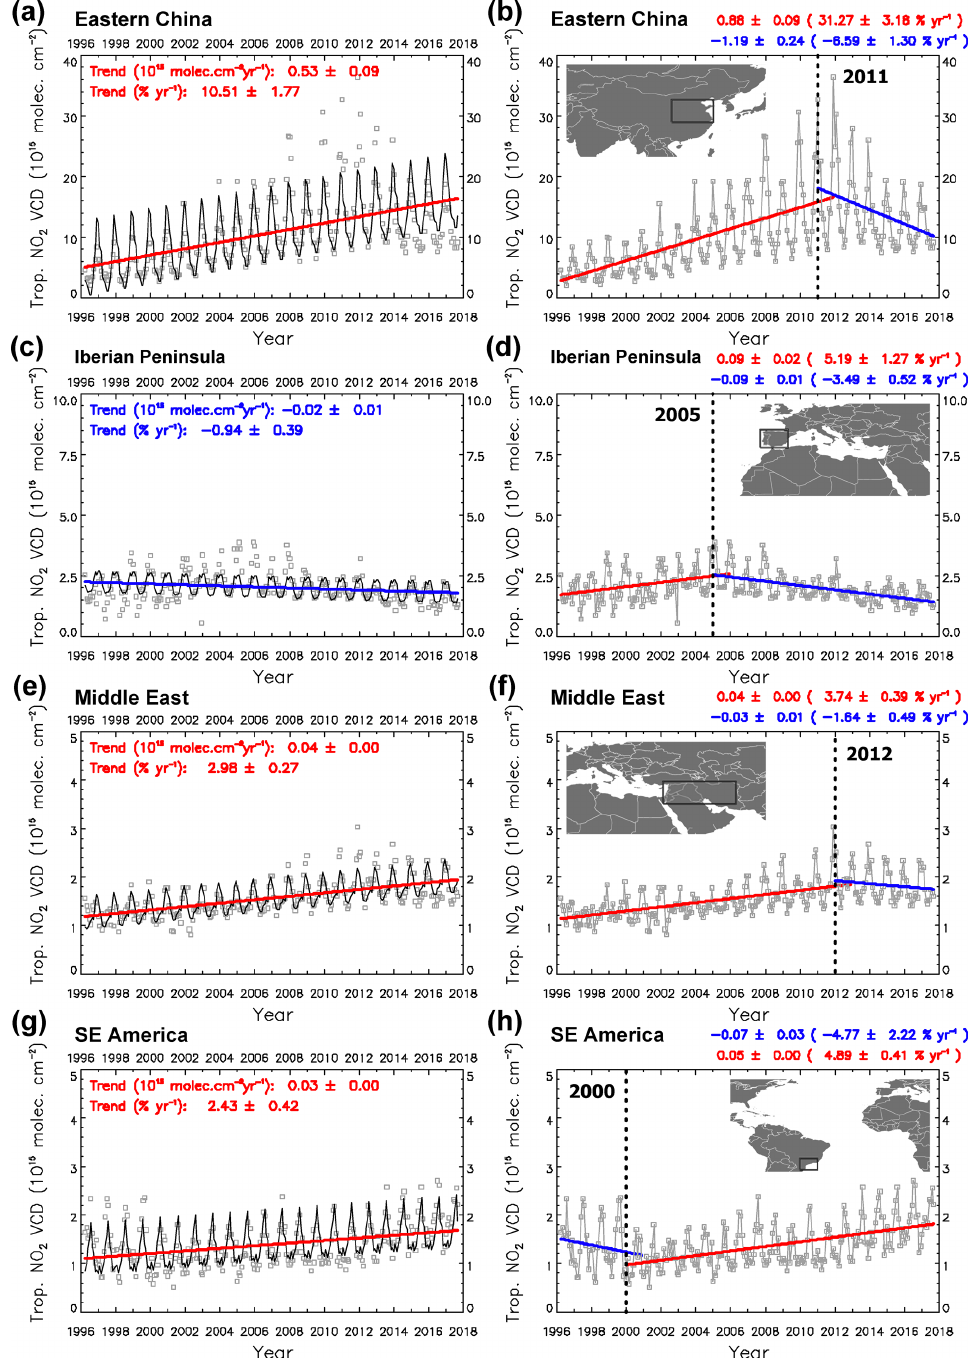
Figure 5. (a, c, e, g) Satellite-based time series (grey points) of tropospheric NO 2 VCD for the period April 1996–September 2017 for eastern China (a) , the Iberian Peninsula (c) , the Middle East (e) , and southeastern America (g) . The black line depicts the fitted time series, and the thick line depicts the trend (solid for statistically significant trends and dashed for statistically insignificant trends at the 95% confidence level; red color for positive trends and blue color for negative trends). The absolute trends (in 10 15 moleculescm − 2 yr − 1 ) and the trends relative to the fitted mean of the first year (in %yr − 1 ) with the corresponding uncertainties ( ± 1 σ ) are given in the plots. (b, d, f, h) Satellite-based time series (grey points and lines) of tropospheric NO 2 VCD for the same regions. The thick lines, similarly to the left column panels, depict the trend for the sub-period before and the sub-period after the detected trend reversal (the year of reversal is included in both sub-periods). The year of the trend reversal is indicated with a black thick dotted line. The absolute trends and the trends relative to the fitted mean of the first year of the sub-periods (in parentheses) with the corresponding uncertainties are given in the plots (upper and lower lines correspond to the fist and the second sub-period, respectively). The regions of interest are also shown in the